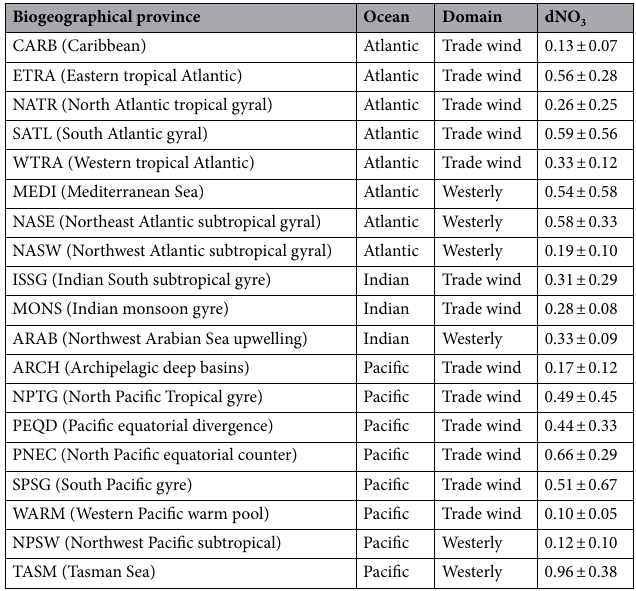
Table 4. Variables for selected biogeographical provinces. Mean ± standard deviation of nitrate diffusive fluxes (dNO 3, mmolN m -2 d -1 ) calculated for the main open ocean biogeographical provinces defined in the Antarctic, Atlantic, Pacific and Indian oceans between 40° N–40° S by Longhurst 34 . Nitrate diffusive fluxes were calculated using the global model